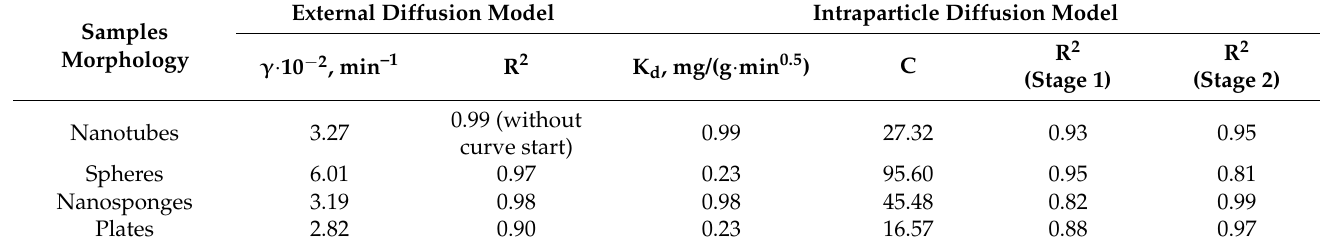
Table 5. The parameters of sorption diffusion models of on the samples with different morphologies.